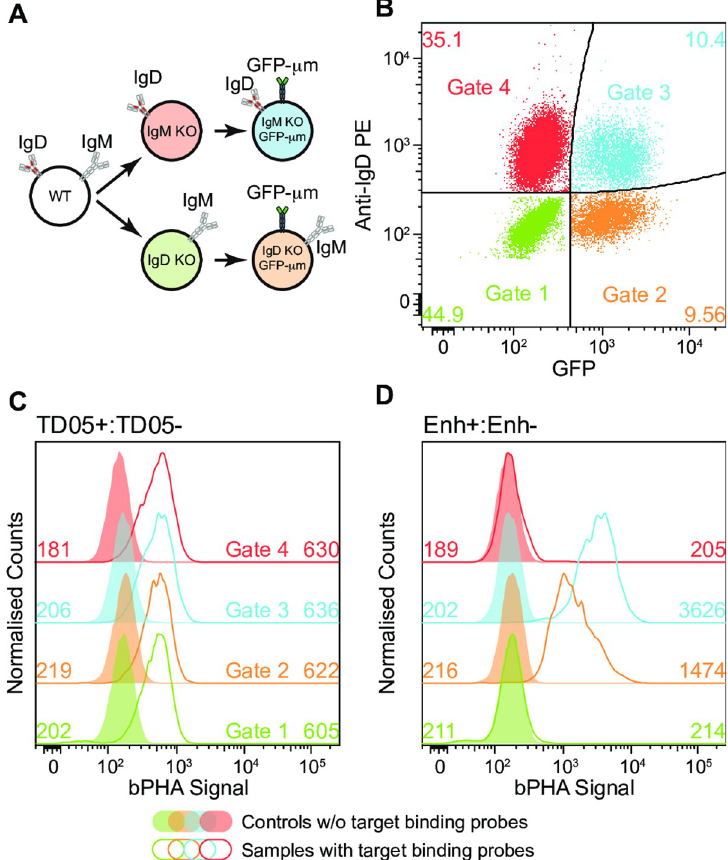
Fig 3. The bPHA works in a mixed cell population. (A) Schematic diagram showing the route map for generating GFP- μ m-expressing IgM or IgD KO cells from WT Ramos B cells by CRSPR/Cas9 method. (B) Flow cytometry results showing that the subpopulations of the mixed cells can be identified by gating for the expression of GFP and anti-IgD staining. (C and D) TD05+:TD05 − (C) or Enh+:Enh − (D) bPHA results were measured by flow cytometry and analyzed by the gating strategy shown in (B). Data represent three independent experiments. bPHA, branched proximity hybridization assay; Enh, Enhancer; GFP, Green fluorescent protein; IgD, immunoglobulin D; IgM, immunoglobulin M; KO, knock-out; PE, phycoerythrin; WT, wild-type.